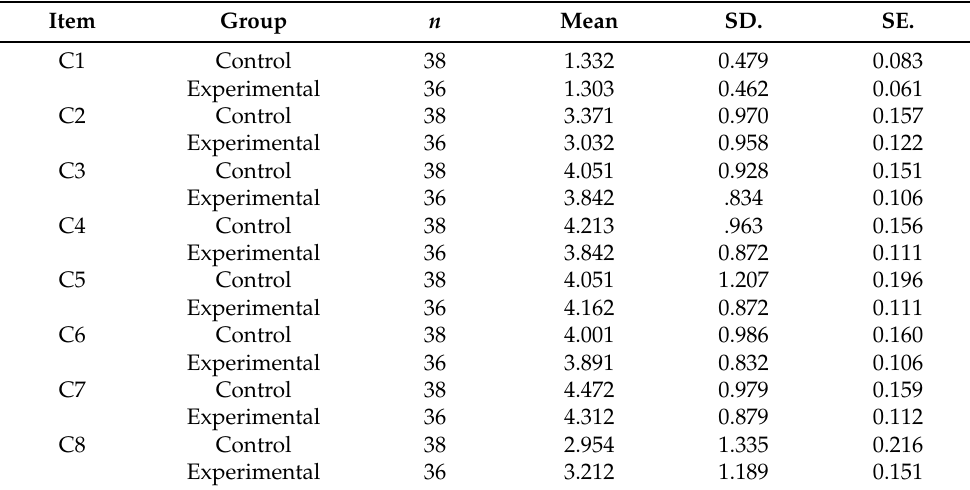
Table 5. Descriptive summary of items from questionnaire Q3 (satisfaction with the teaching method, Table